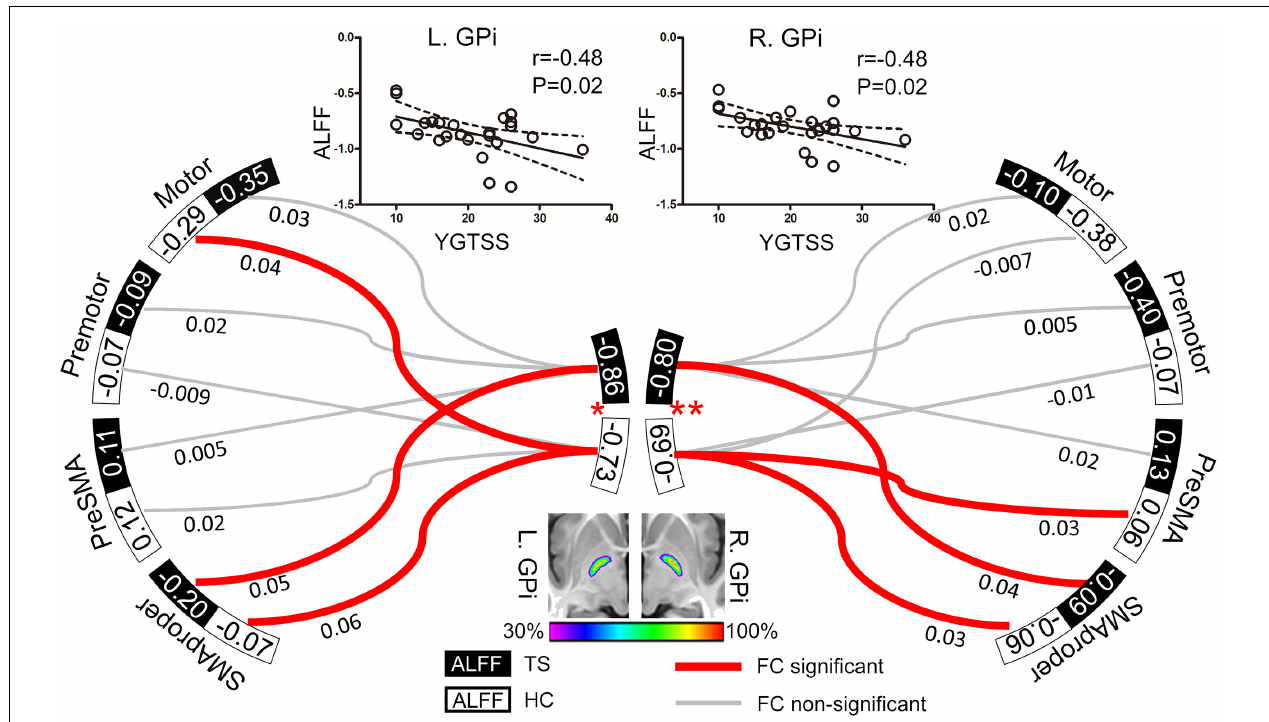
FIGURE 1 | Resting GPi hypofunction and preserved GPi-SMA proper connectivity in TS patients. Middle bottom image illustrates the population-based probabilistic map for bilateral GPi in 29 subjects (14 patients and 15 controls). Local resting activity was lower in bilateral GPi of TS patients than matched controls ( ∗ P < 0.05, ∗∗ P < 0.01). Significant functional connectivity was found between SMA proper and GPi in bilateral hemispheres in both patient and control groups, with no significant between-group difference. The ALFF values of bilateral GPi were significantly correlated with YGTSS, an index of TS severity. The dash line represents the 95% confidence band of the best-fit line. Values nearby curves represent correlation coefficient after Fisher’s z